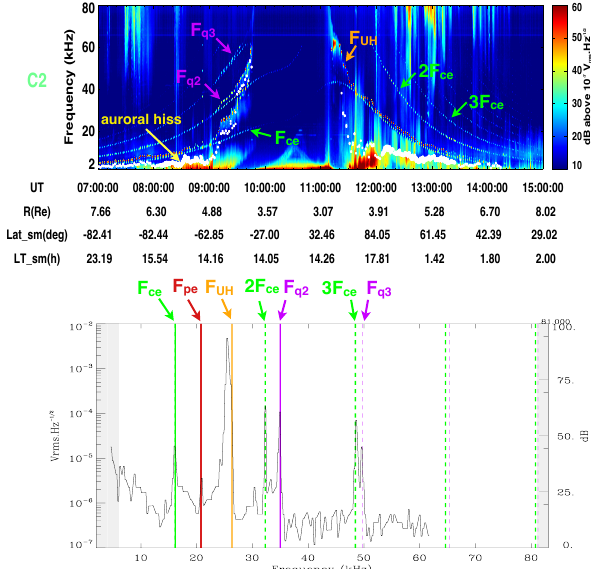
Fig. 2. Example of an asymmetric plasmasphere crossing, on 9 Au- gust 2007, 07:00–15:00UT. Top panel shows the spectrogram recorded by C2. Bottom panel displays a spectrum recorded at 09:16:10UT. Typical resonances observed in the plasmasphere are indicated on both panels by arrow of given colours: orange for up- per hybrid frequency ( F UH ), green for gyro-harmonic ( nF ce ) and purple for Bernstein modes ( F qn ). The plasma frequency F pe de- rived from the diagnostic is plotted as white dots in the top panel (it is an identified resonance pointed by a red arrow in the bottom panel). Auroral hiss emissions (top panel) are pointed by a yellow